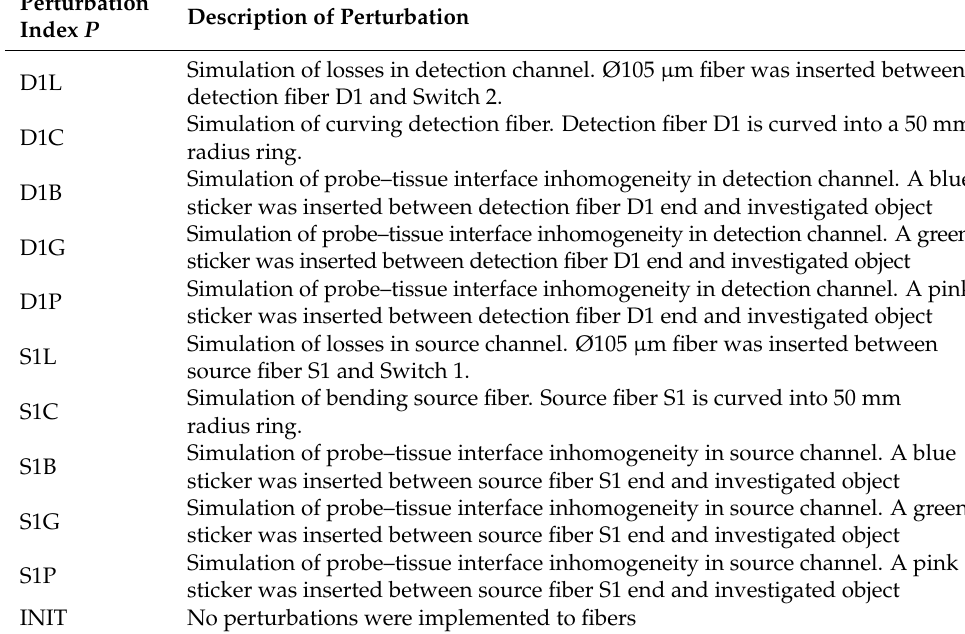
Table 1. Description of instrumental perturbations used in phantom and in vivo